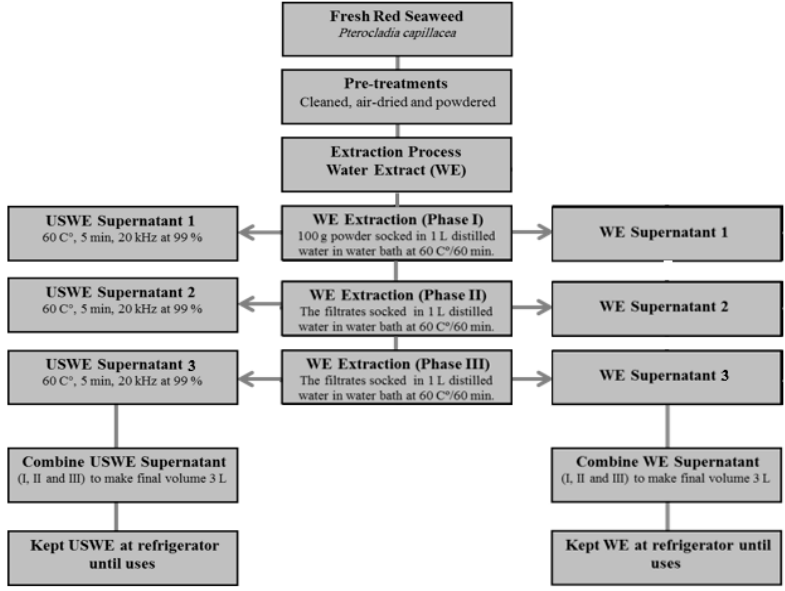
Figure 1. Procedures for water extraction (WE) and ultrasound-assisted water extraction (USWE) of pre-treated Pterocladia capillacea .